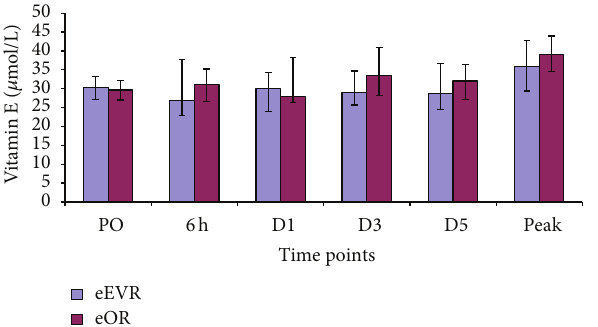
Figure 9: Serum lycopene levels expressed as median and